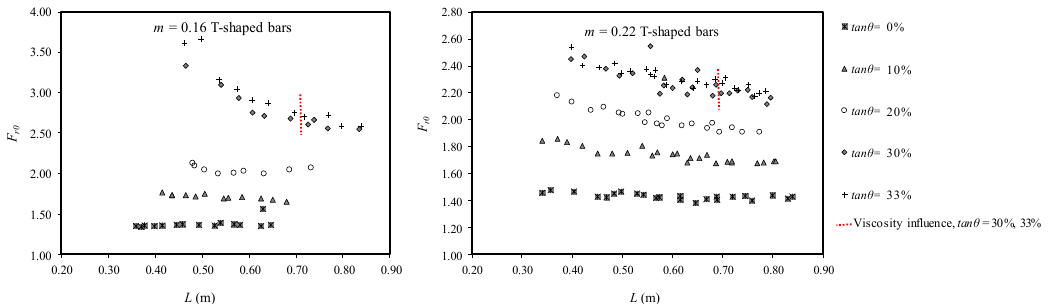
Figure 13. Froude number at the beginning of the rack F r0 as a function of the wetted rack length for T-shaped flat bars with void ratios m = 0.16 and 0.22.